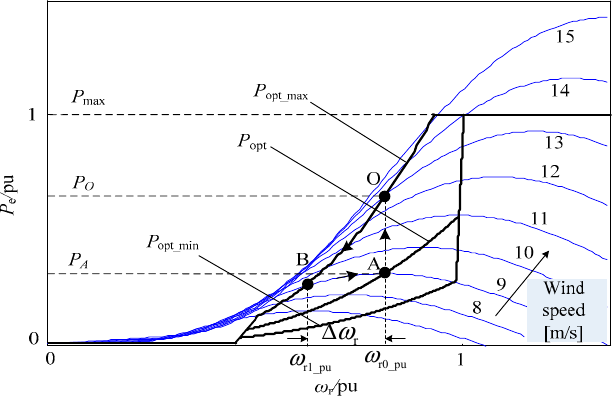
Figure 8. Switching principle of improved MPPT curve.